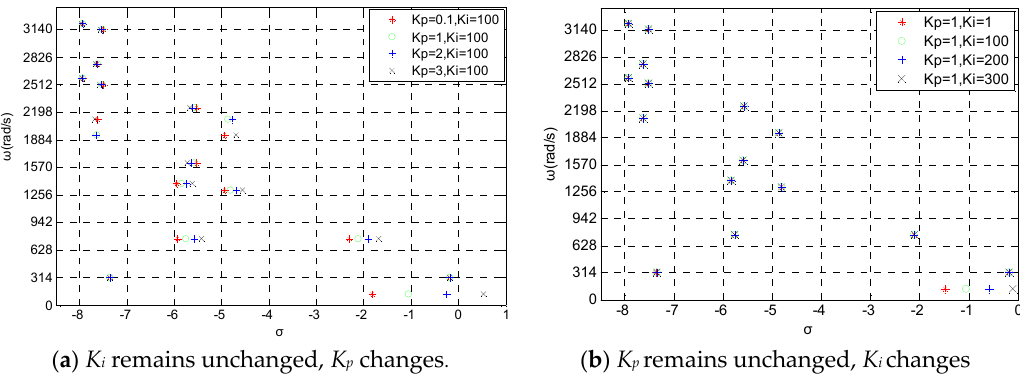
Figure 9. Variation trend of eigenvalues of the electromagnetic oscillation mode with SVC PI parameters (1000 km transmission line).